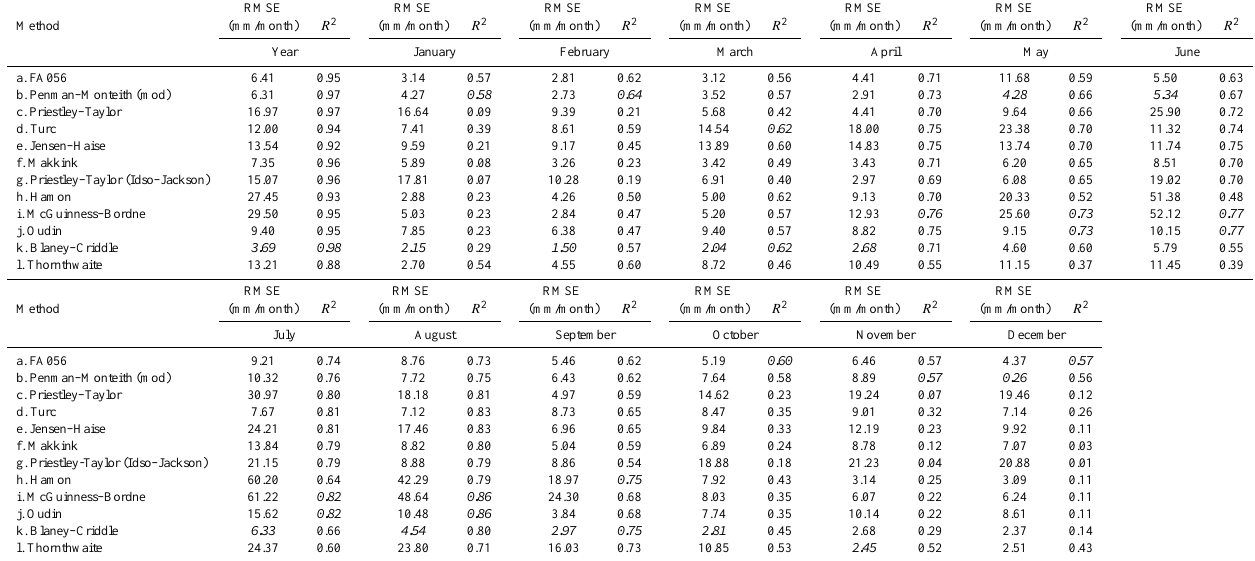
Table 3. Statistical fit between paired mean monthly MORECS and HadRM3-Q0-driven PET calculated over the 1961–1990 time slice for 12 PET equations for the year and four typical months. Values are paired by MORECS grids. HadRM3-Q0-driven PET was calculated at 5km grid and aggregated to MORECS grid for comparison. Values in italic highlight the smallest error or closest fit in each